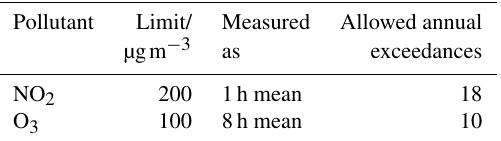
Table 2. UK air quality objectives (Defra, 2019). Note that the UK has adopted the EU NO 2 limit as a part of its air quality objectives but improves upon the O 3 obligations, where O 3 must not exceed 120µgm − 3 more than 25 times per year in a given 3yr window (EEA,